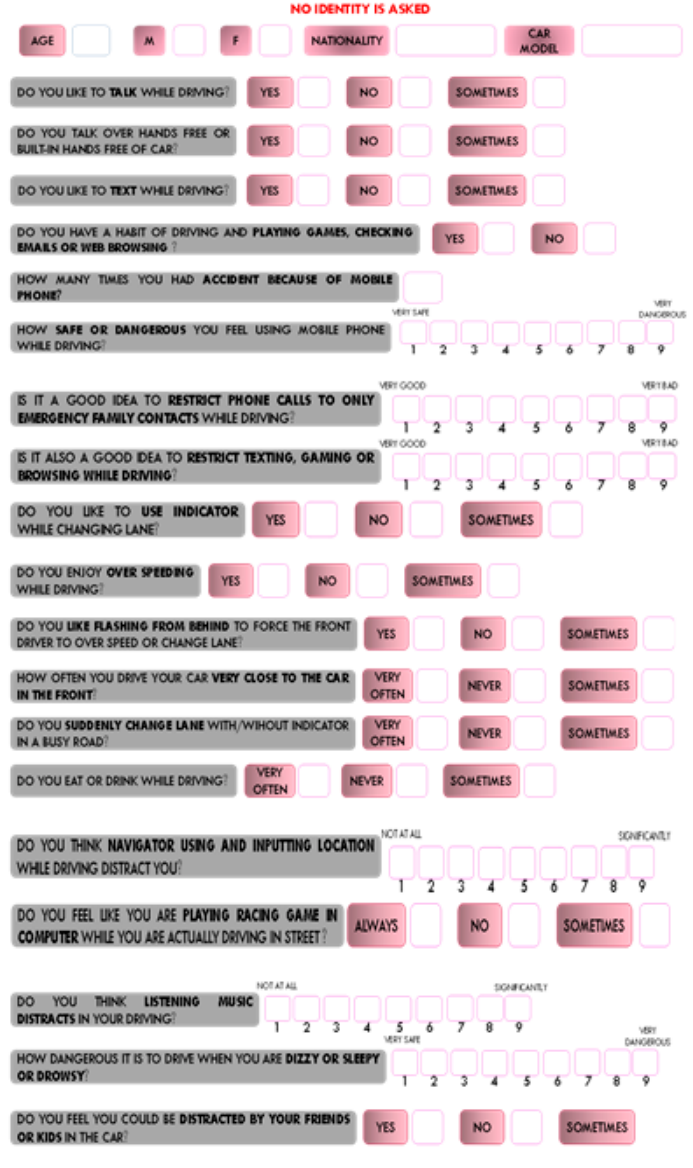
Figure A1. Survey questionnaire.